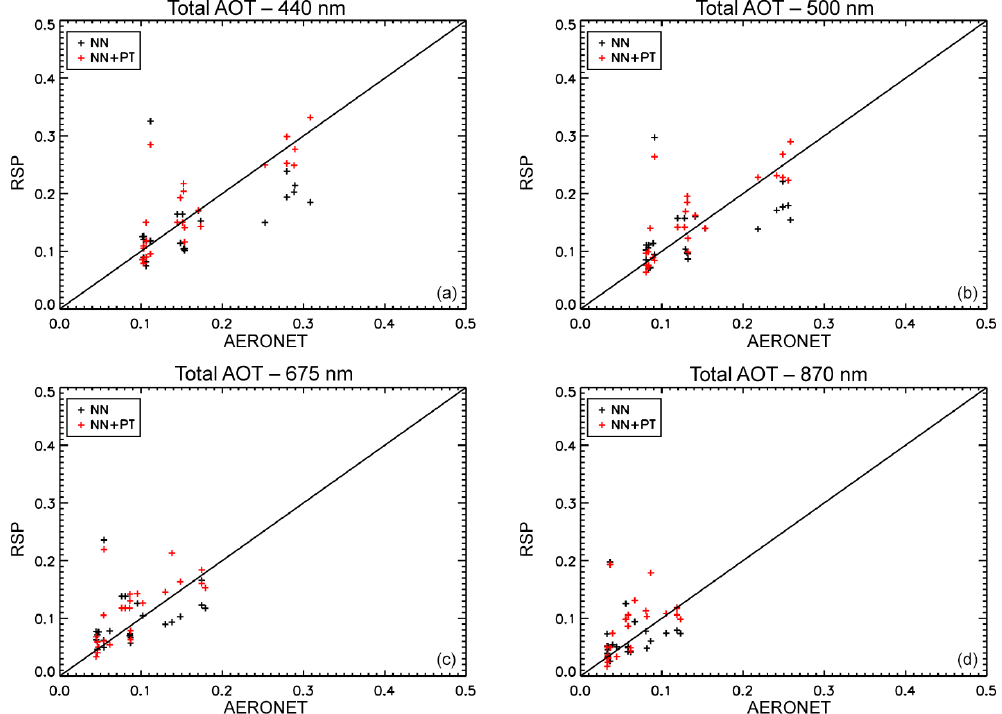
Figure 12. RSP versus AERONET total AOT at the four AERONET wavelengths lying inside the spectral range of the RSP measurements used in this study. Black crosses: neural network retrievals. Red crosses: Phillips–Tikhonov with neural network first guess. Statistics shown in Table 6.